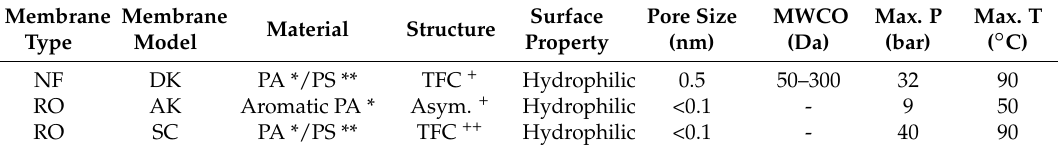
Table 1. Membranes’ specifications.